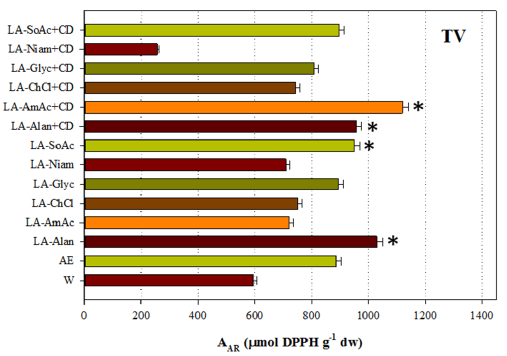
Figure 2. Plot showing the A AR of the extracts obtained. Asterisk denotes statistically higher value ( p < 0.05). Assignments: CC, Coridothymus capitatus ; OV, Origanum vulgare ; SF, Salvia fruticosa ; SO, Salvia officinals ; TV, Thymus vulgaris .